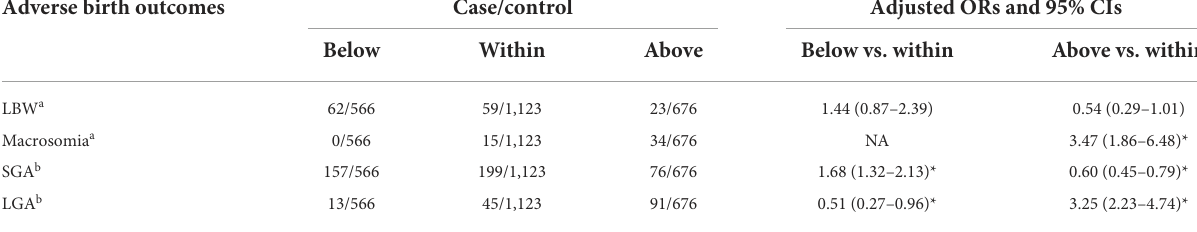
TABLE 2 Associations between adverse birth outcomes and GWG categories according to IOM guidelines. Adverse birth